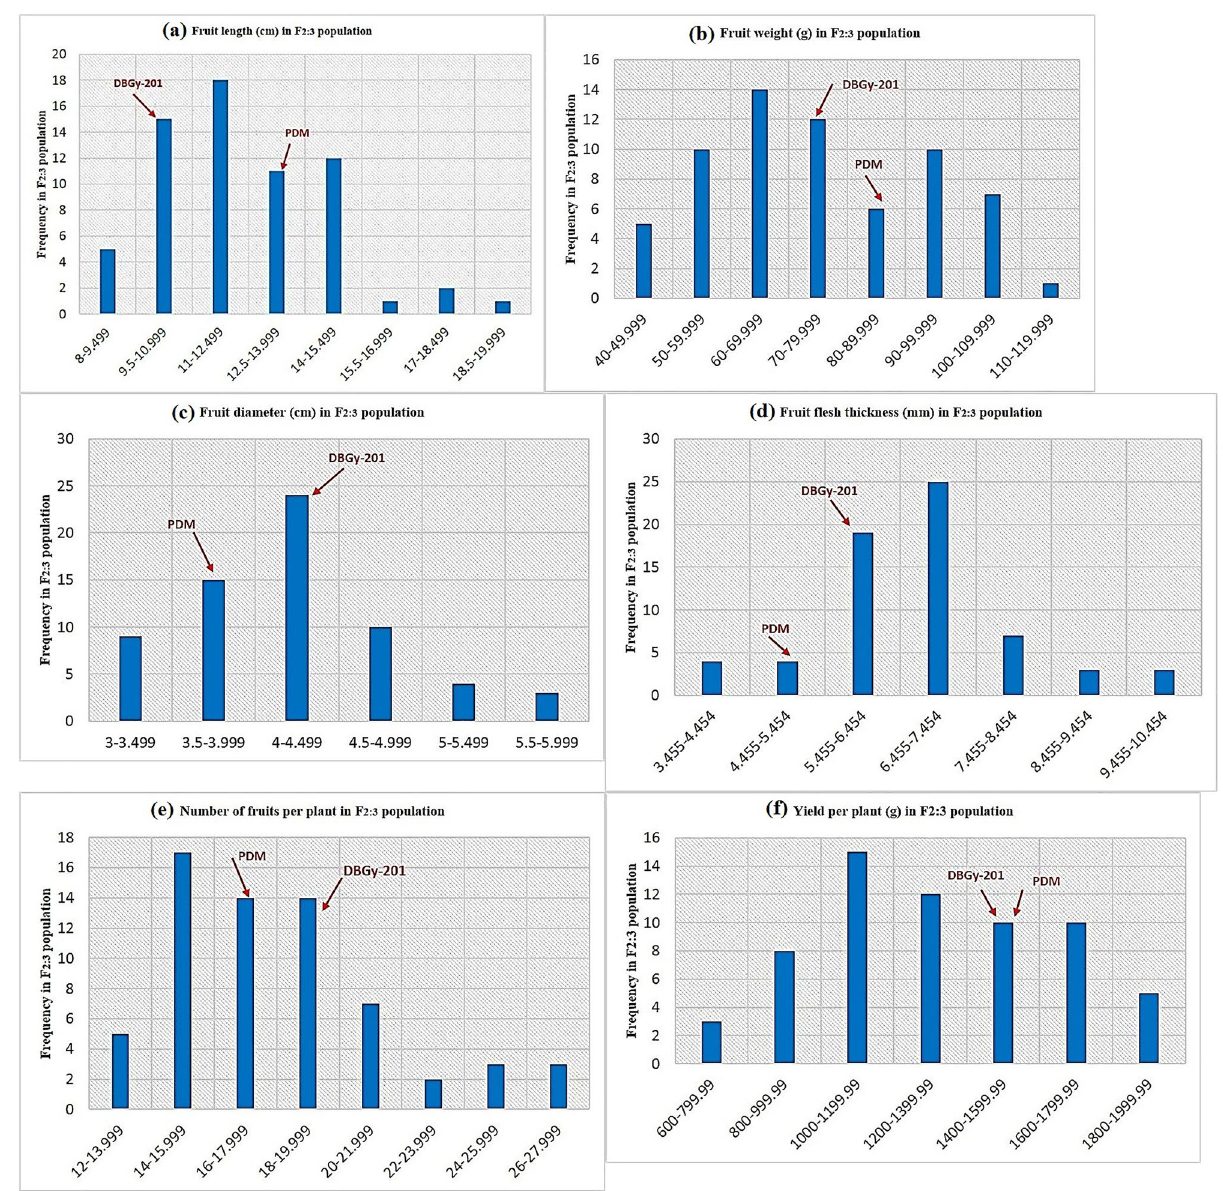
Figure 1. Frequency distribution pattern of mean trait values of F 2:3 family (≈ 20 plants from each family by taking an average of five fruits per plant) from the cross DBGy-201 × Pusa Do